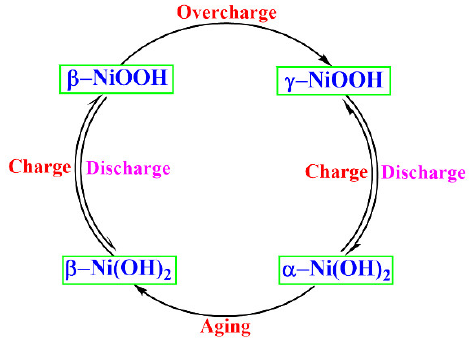
Scheme 1. Bode’s Diagram for Ni(OH) 2 –NiOOH redox